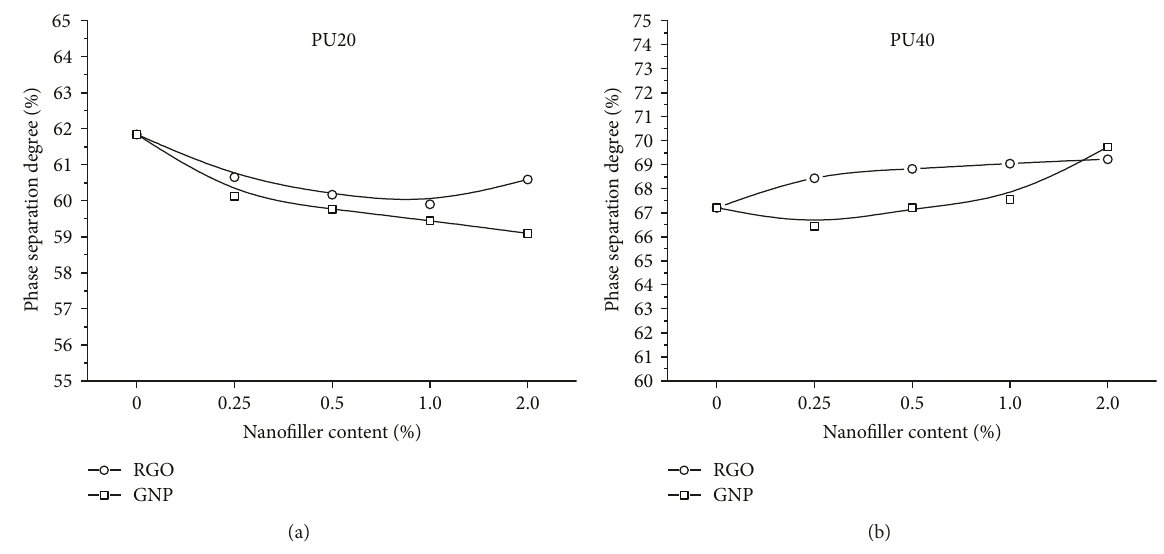
Figure 8: Phase separation degree (PSD) for (a) PU20 and (b) PU40